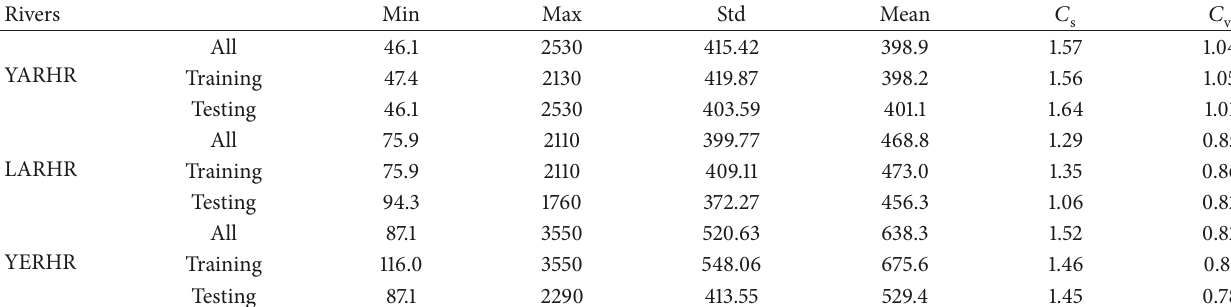
Table 3: Statistical parameters of runoff data in each data